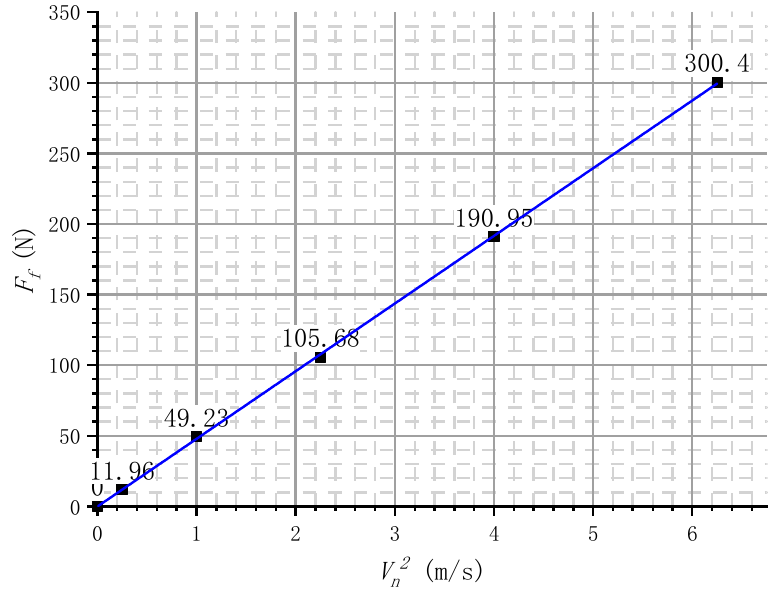
Figure 15. Relation curve between V n2 and F f.